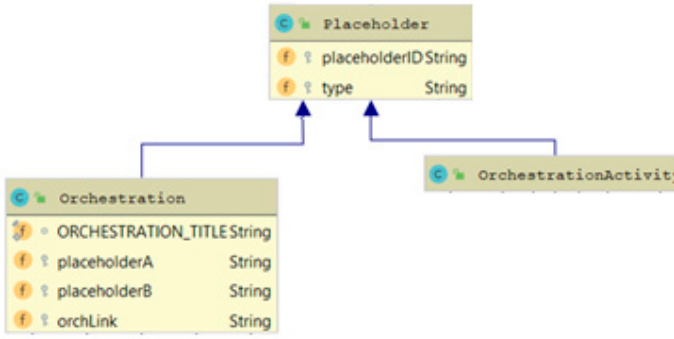
Figure 28. Descriptive overview of Placeholder class and its subclasses.